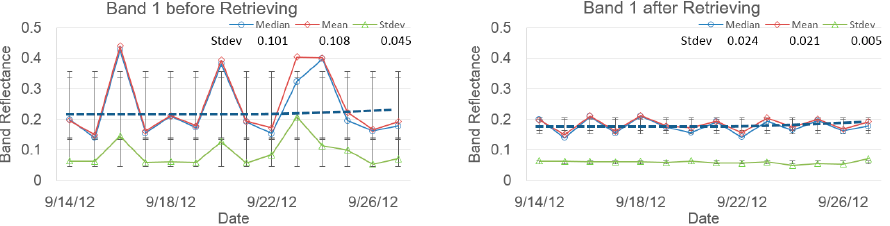
( a - left ) Band 1 before retrieving ( a - right ) Band 1 after retrieving ( a - right ) Band 1 after retrieving Figure 5.